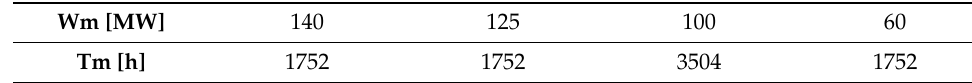
Table 2. Parameters of the cumulative load [56].